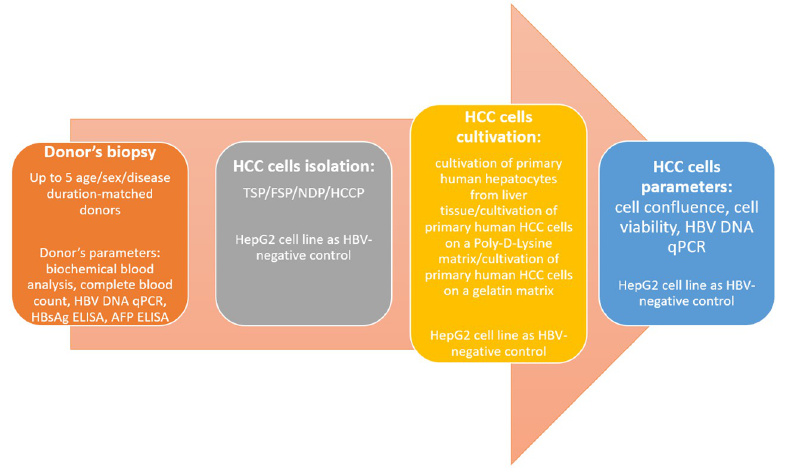
Fig 1. Graphics pipeline of HCC cell protocols